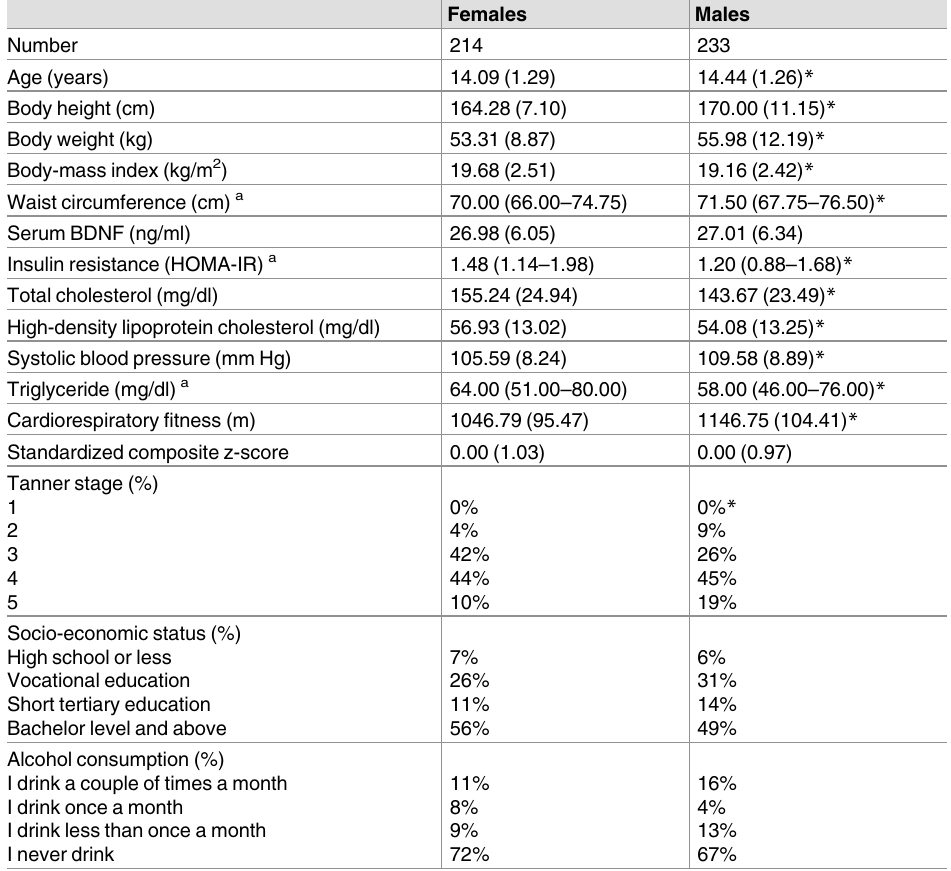
Table 1. Characteristics of the study population stratified by